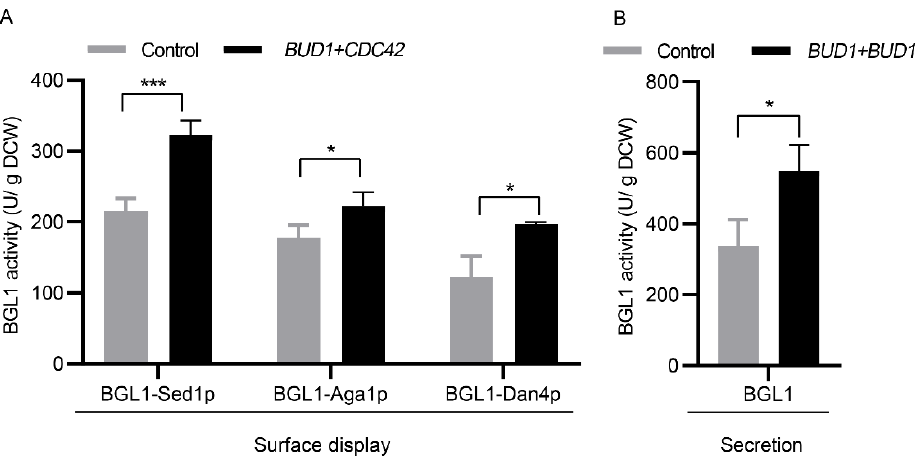
Figure 4. Engineering cell polarization enhanced the surface-displayed ( A ) and secretion ( B ) of BGL1. All strains were cultivated in the SC − AA medium without uracil at 30 °C for 24 h. Data are mean ± SD from three independent experiments. The statistical significance of enzymatic assays was determined by a two − tailed homoscedastic (equal variance) t -test and one asterisk represents p < 0.05, and three asterisks represents p < 0.005.